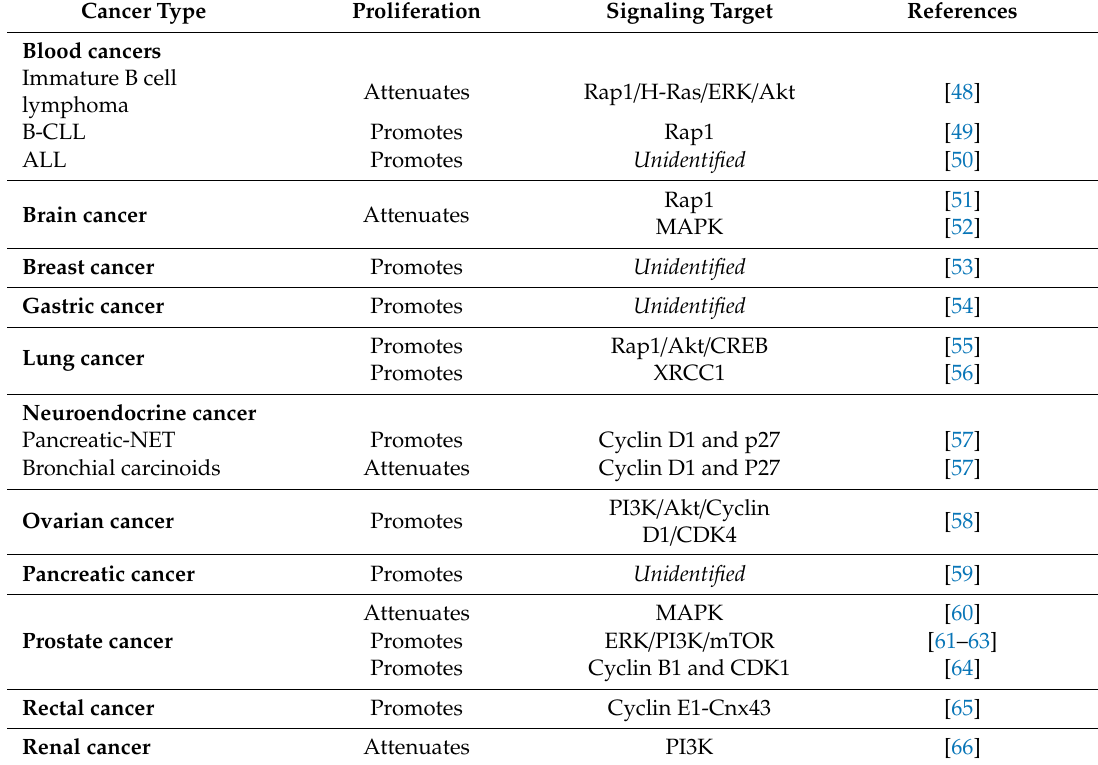
Table 1. Role of Epac in cancer cell proliferation and its downstream signaling